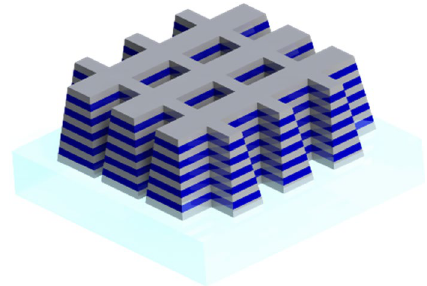
Figure 1. Fishnet metamaterial made of superposed layers of